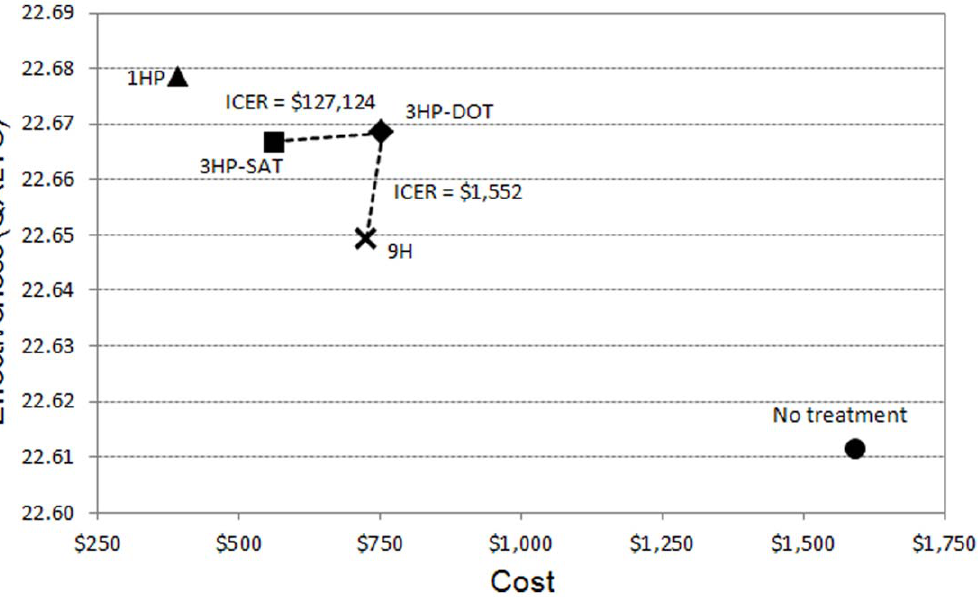
Figure 1. Cost-effectiveness plot of the four regimens and the ‘‘no treatment’’ strategy. Incremental cost-effectiveness ratios (ICER) are represented by the inverse slope of the dotted and dashed lines between strategies. Abbreviations: 9H=isoniazid daily for 9 months, 3HP=isoniazid plus rifapentine weekly for 3 months, 1HP=isoniazid plus rifapentine daily for 1 month. SAT=self-administered therapy, DOT=directly-observed therapy . doi:10.1371/journal.pone.0022276.g001 PLoS ONE |